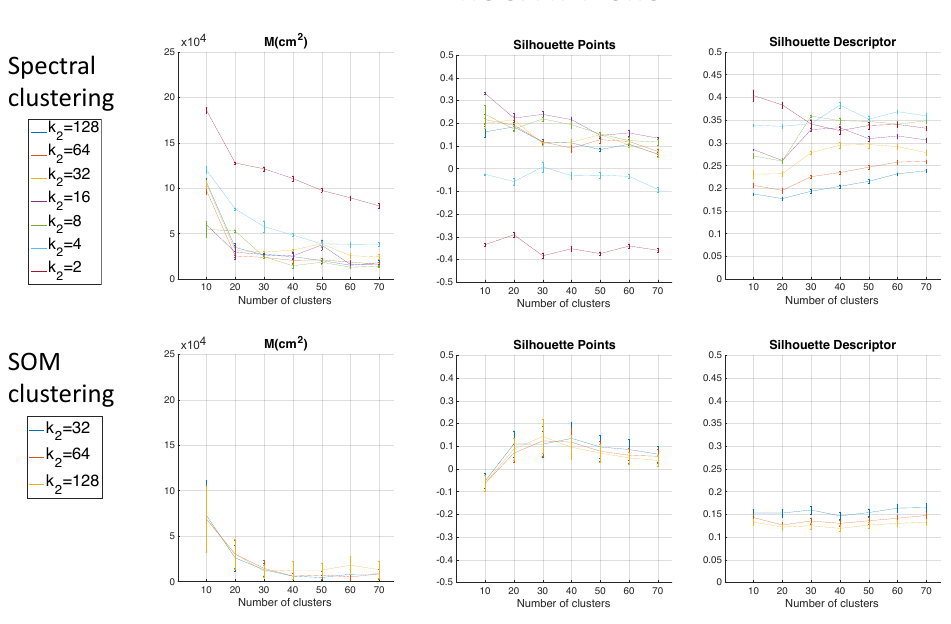
Figure 11. Results of the two clustering methods: average moment of inertia, average silhouette of points, and average silhouette of descriptors vs. number of clusters, when using HOG in the Freiburg